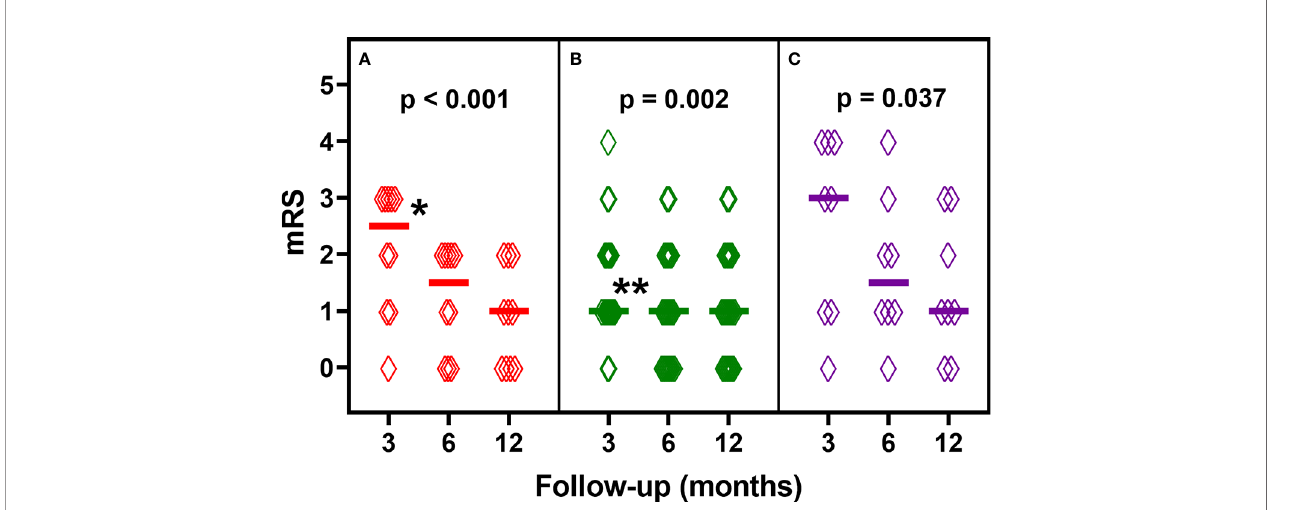
FIGURE 2 | Longitudinal analysis of modi fi ed Rankin Scale (mRS) scores of patients who have completed all follow-ups at 3, 6 and 12 months: (A) anti-NMDAR- antibodies (n=10), (B) anti-LGI1/CASPR2-antibodies (n=22), (C) other antibodies (n=8). Diamonds indicate individual patients ’ scores. Horizontal lines show median mRS scores. P-values are derived from Friedman ’ s test. *p < 0.0167 for post-hoc two-group comparisons (3 vs . 6 months and 3 vs . 12 months). **p < 0.0167 for post-hoc two-group comparisons (3 vs. 6